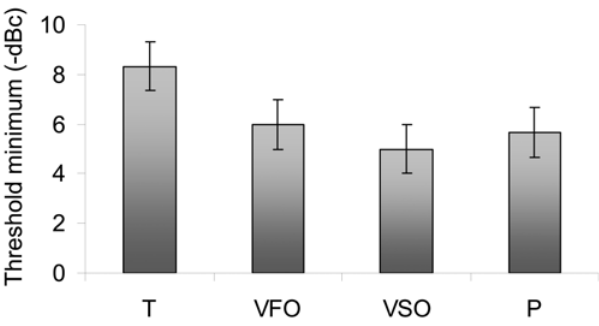
Figure 9. Crossmodal SR threshold minima in ceiling decibels. Shows the averaged SR minima for the four experiments discussed. For our visual experiments the minima are localized (below the noise ceiling levels) at 6 6 1 dBc (first order) and 5 6 1 dBc (second order). In the proprioception experiments the minima happened around 6 6 1 dBc and for the tactile experiments at 8 6 1 dBc.